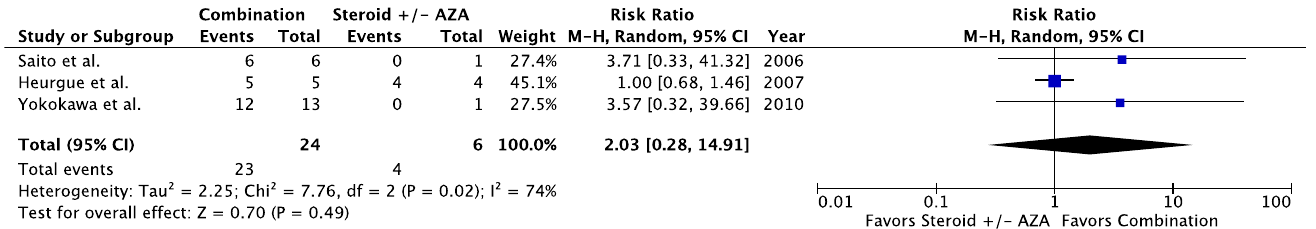
Figure 7. Biochemical improvement in AIH-PBC patients treated with combination therapy vs. immunosuppression. Steroid = corticosteroids, AZA = azathioprine, Combination = UDCA + corticosteroids  AZA.